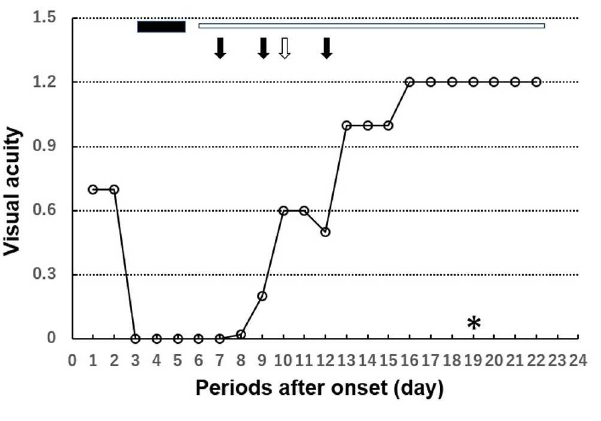
TABLE 1 | Clinical course with visual acuity and